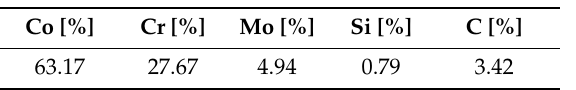
Table 1. Percentages of chemical elements.